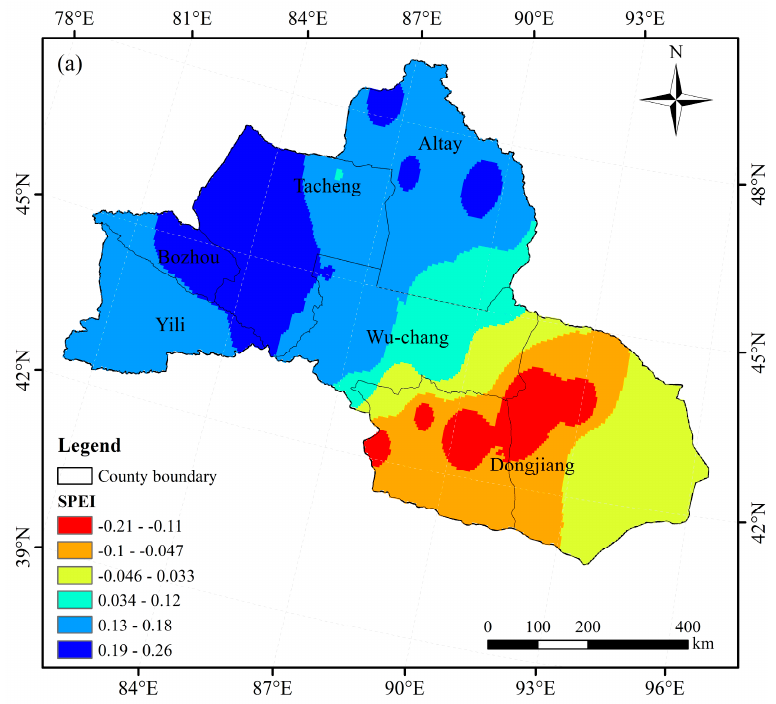
Figure 3. Spatial patterns of average values in the SPEI in NXC from 1960 to 2015.